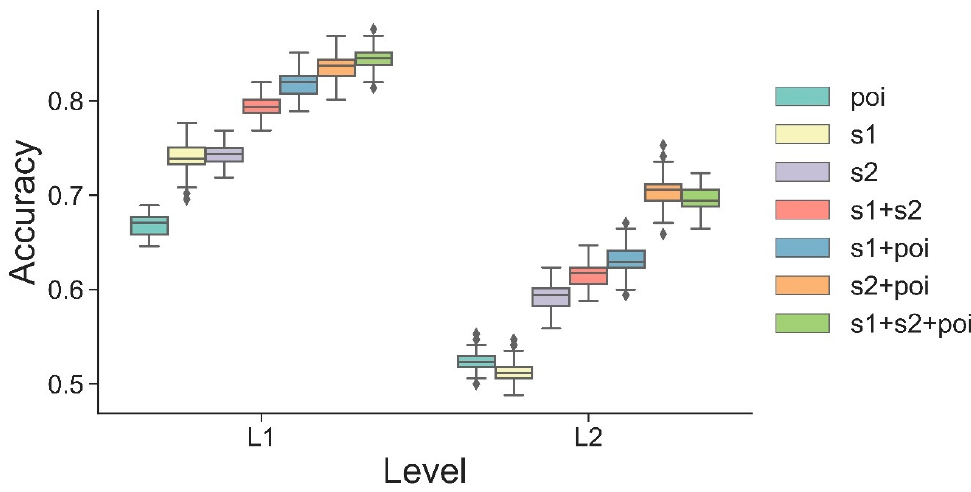
Figure 3. Accuracies of EULUC-seg for Level I and Level II categories using different combinations of features. poi, s1, and s2 denote features from data sources of Baidu POIs, Sentinel-1 SAR, and Sentinel- 2 optical, respectively. For each scenario, the random forest (RF) model is repeated 100